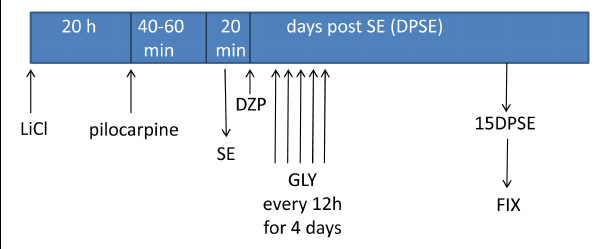
Frontiers in Cellular Neuroscience |